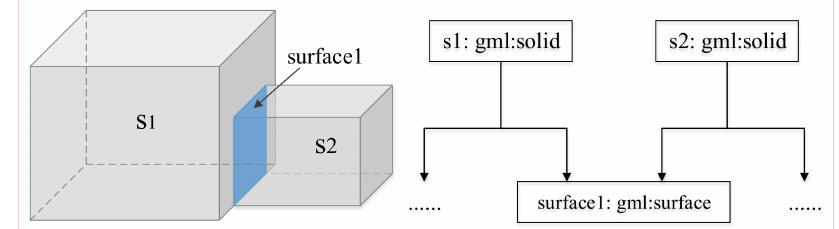
Figure 2. Representation of topology by XLinks.